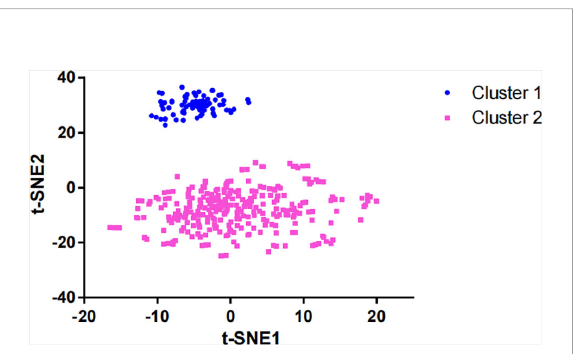
FIGURE 1 Dimension reduction of data by the t-SNE algorithm t-SNE, t- distributed stochastic neighbor embedding.